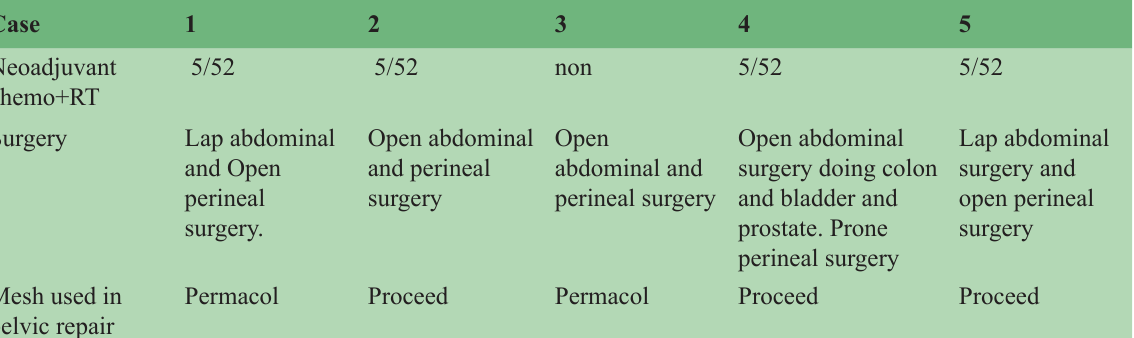
Table 2: Treatment received Case